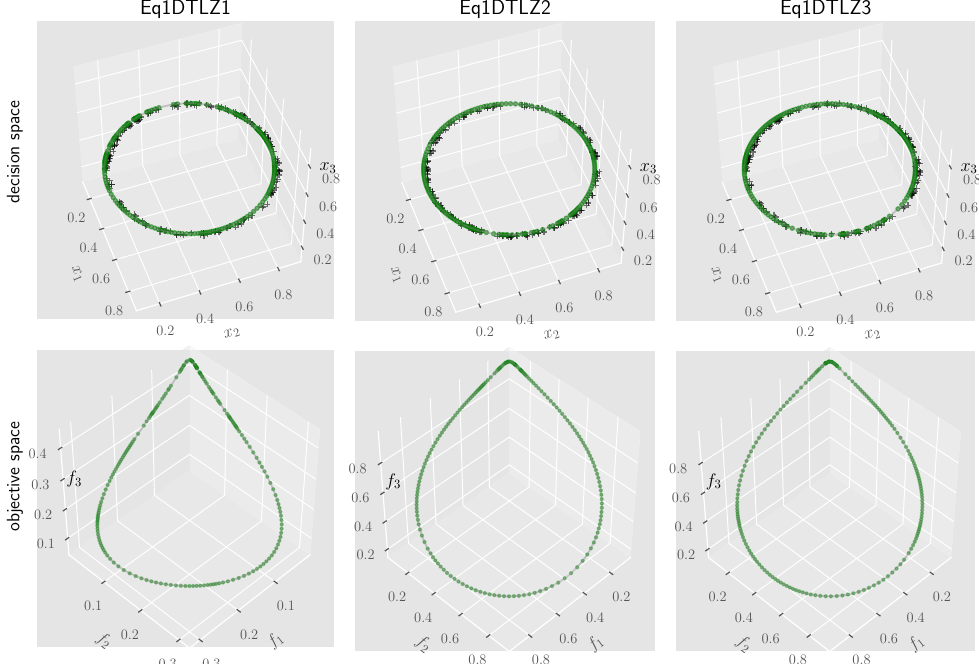
Figure 5. On Eq-DTLZ1-3 problems, the HVN method starts from a small local perturbation (black crosses) of the Pareto set (sphere in the decision space), i.e., X ∗ + 0.02 sampled uniformly at random on the Pareto set. The final approximation set of the HVN method is depicted as green points. Only the first three search dimensions are shown for the decision space.